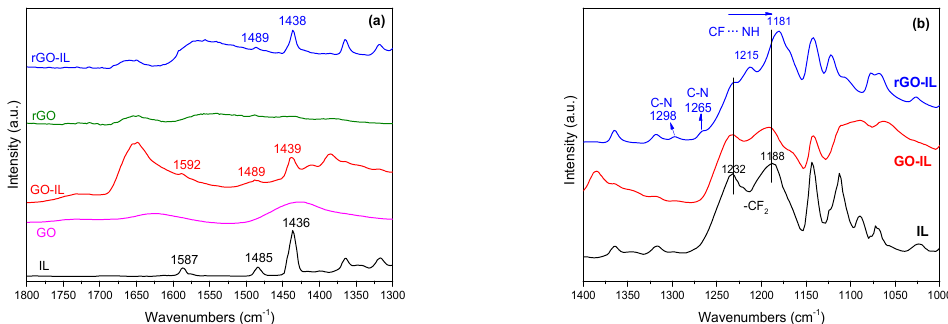
Figure 8. ATR FTIR spectra of IL, GO-IL, and rGO-IL in the range of wavenumbers from 1300 to 1800 cm − 1 ( a ) and from 1400 to 1000 cm − 1 ( b ).